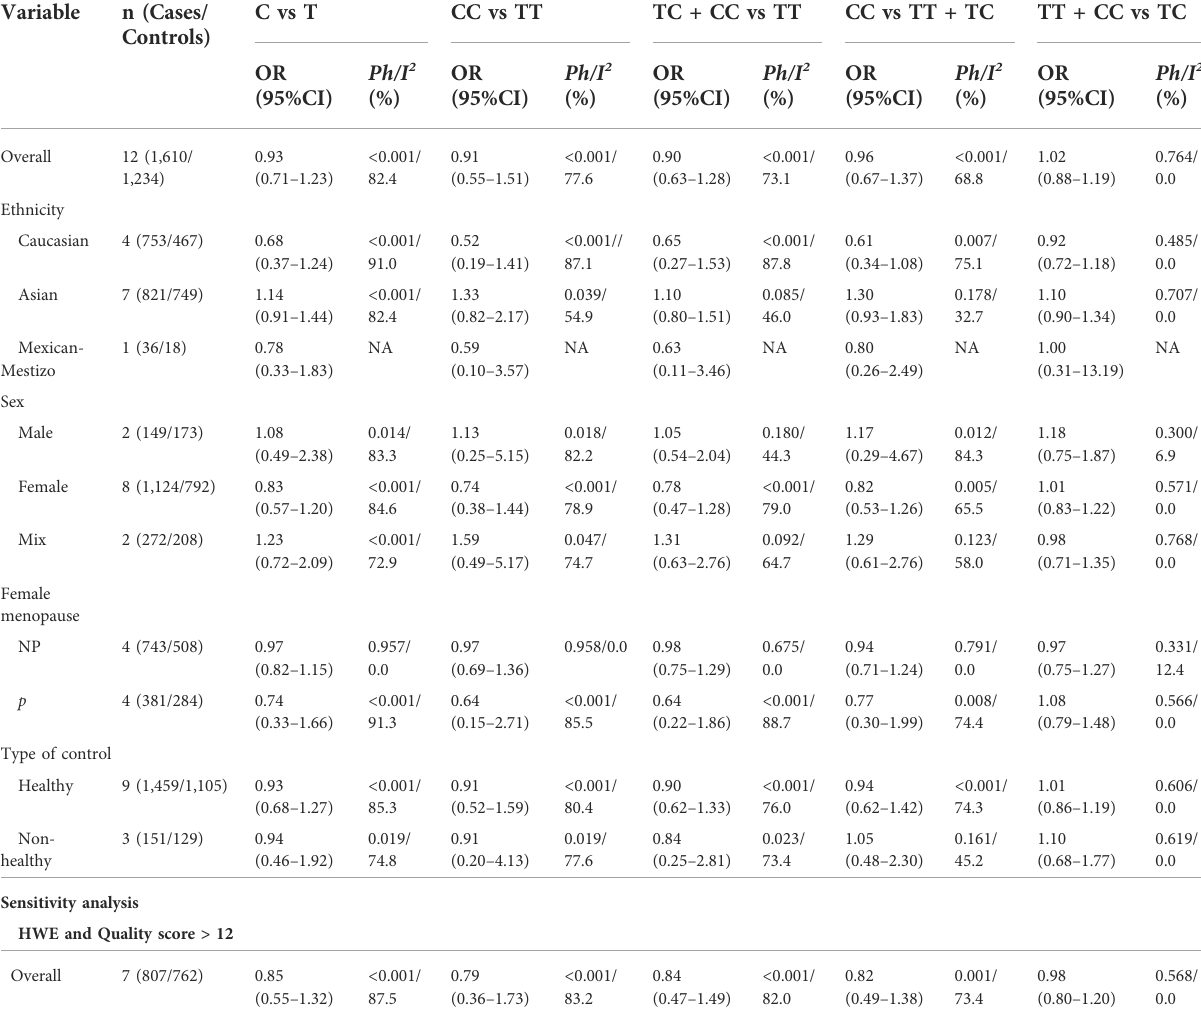
TABLE 3 Meta-analysis of the association of OPG T950C polymorphism with risk of osteoporosis.